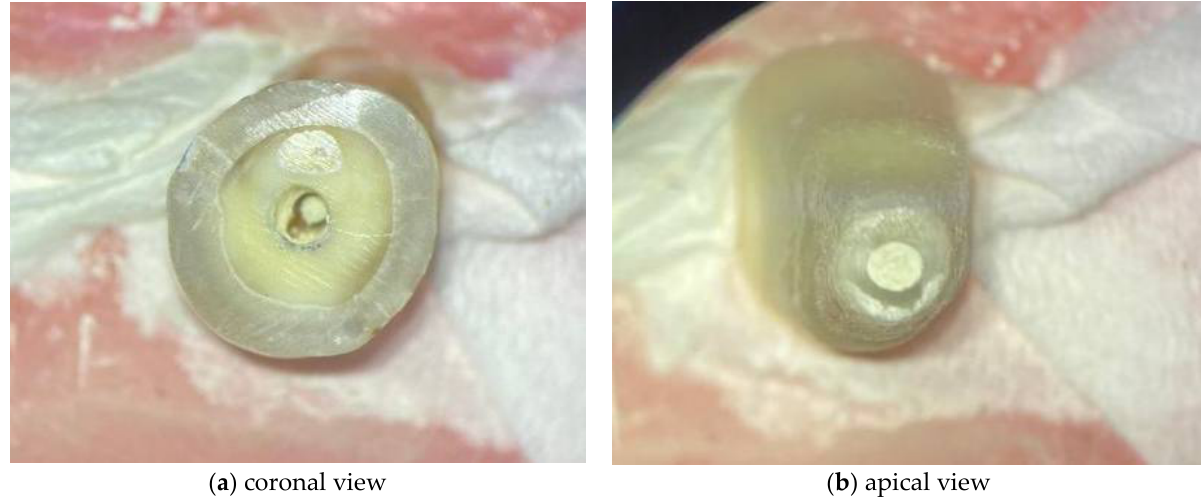
Figure 2. Images acquired under optical microscope for demonstrating the 4 mm apical plugs.